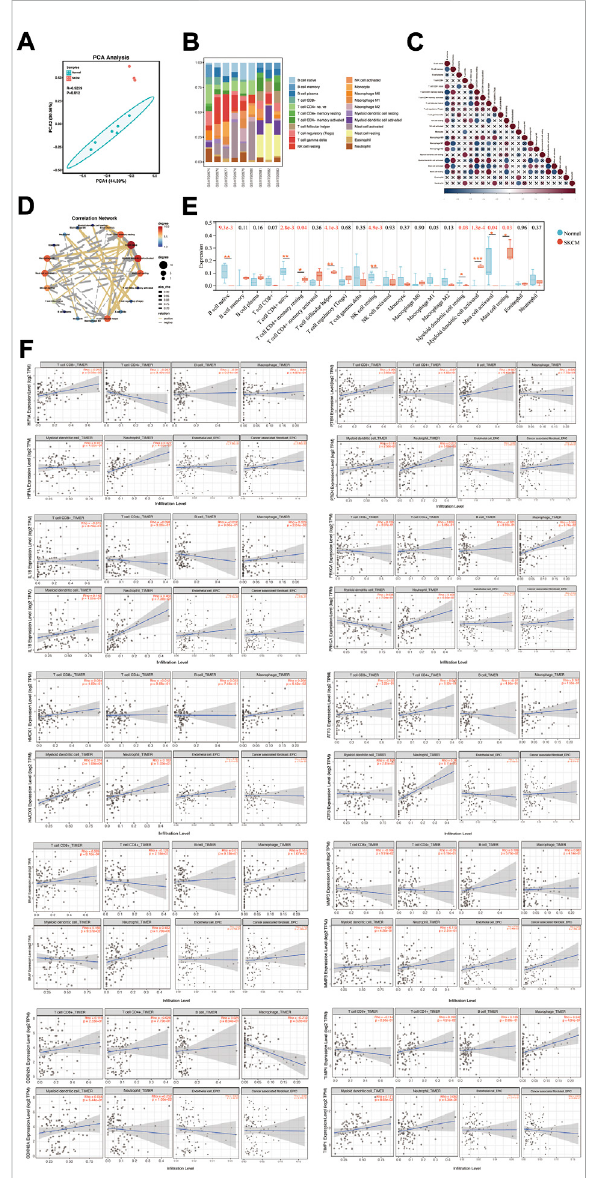
FIGURE 7 Immunecellin fi ltrationstatusinSKCM. (A) PCAclusterplotof immune cell in fi ltration between melanoma cell lines and health controls. (B) Histogram showed the composition of 22 kinds of immune cells in both samples. (C) Correlation heat map of 22 types of immune cells. The size of the colored squares represents the strength of the correlation; blue represents negative correlation, red represents a positive correlation. “ × ” represents p value > 0.05. (D) Correlation network map showed a connected network with immune cells. p value < 0.05, and Rho ≥ 0.5 or Rho ≤ − 0.5 were showed in the network map. (E) Box diagramofthein fi ltrationofimmunecellsbetweenthetwogroups of samples. * p < 0.05; ** p < 0.01; *** p < 0.001. (F) Correlation between different expressed hub genes and immune cell in fi ltration in